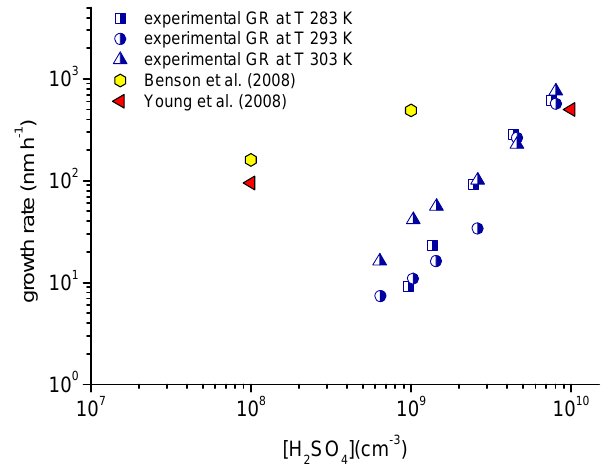
Figure 12. The experimental growth rates determined from mea- surements conducted at an RH of 30%, a residence time of 90s and three nucleation temperatures are compared with the particle growth rates measured in the nucleation experiments made by Benson et al. (2008) at T = 288K and Young et al. (2008) at T =